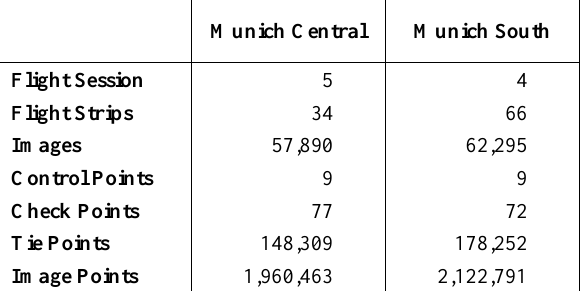
Table 9. Munich production blocks’ statistics.